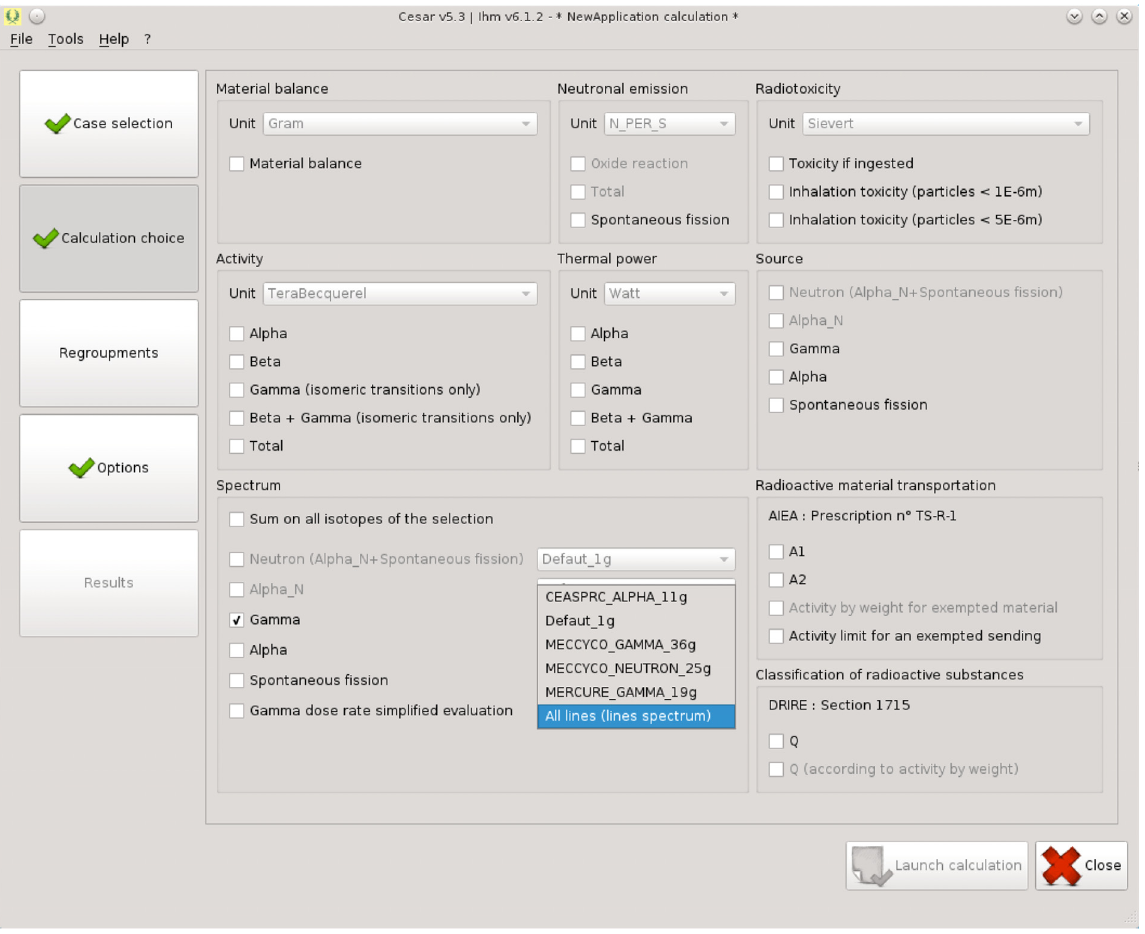
Fig. 2. Selection of desired parameters. Table 3. CESAR libraries dedicated to CEA